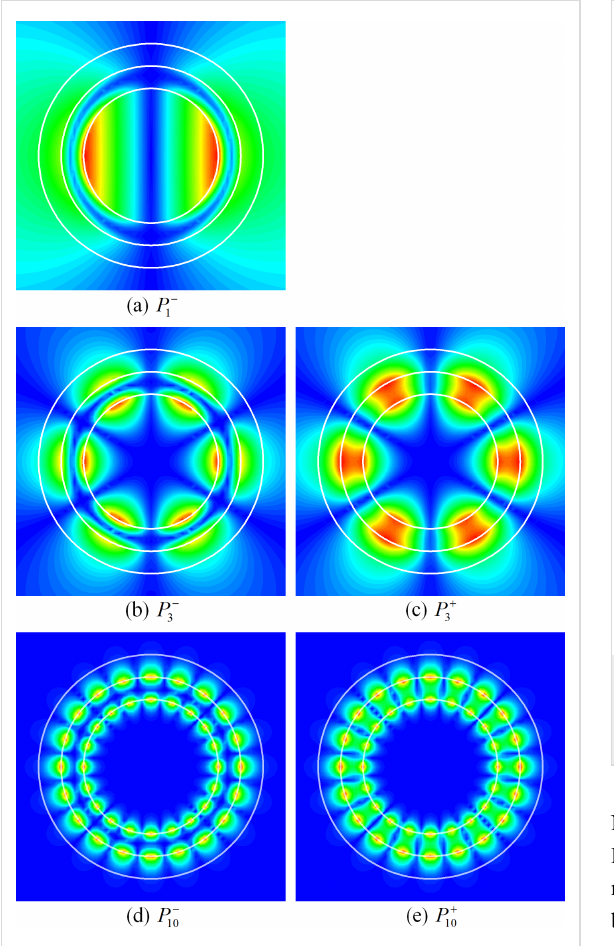
Figure 3: Near H-fields of the eigenmodes of thin-wall nanotube, a = 30 nm and h = d = 10 nm: (a) λ = 565.031 nm, γ = 0.122, (b) λ = 414.238 nm, γ = 0.035, (c) λ = 335.46 nm, γ = 0.269, (d) λ = 363.737 nm, γ = 0.073, (e) λ = 354.361 nm, γ = 0.105.